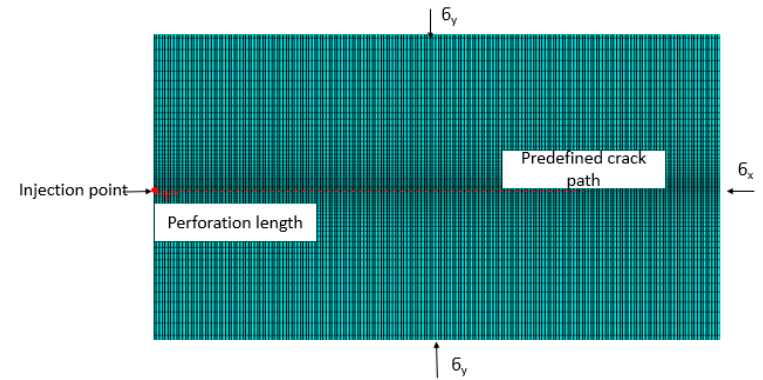
Figure 1. 2D crack in plane-strain condition. Table 1. All the parameters used in numerical simulation.